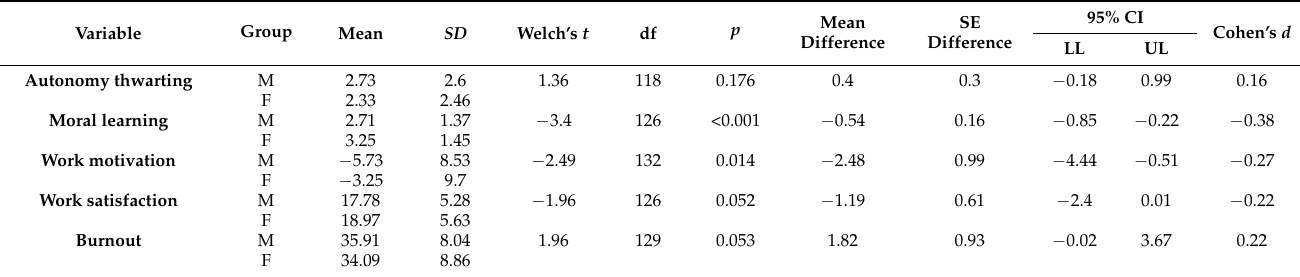
Table 2. Differences in variables of interest according to self-identified